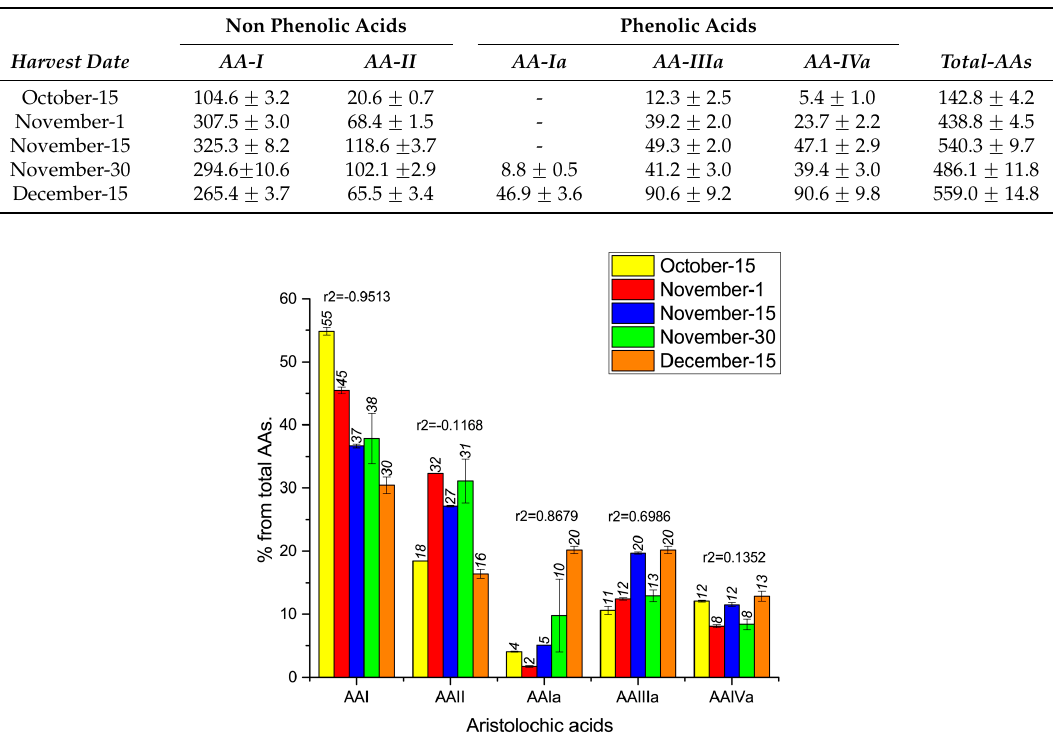
Figure 2. Variation during springtime of the percentage (%) of each aristolochic acid (AA), in the total AAs mixture from leaves samples.